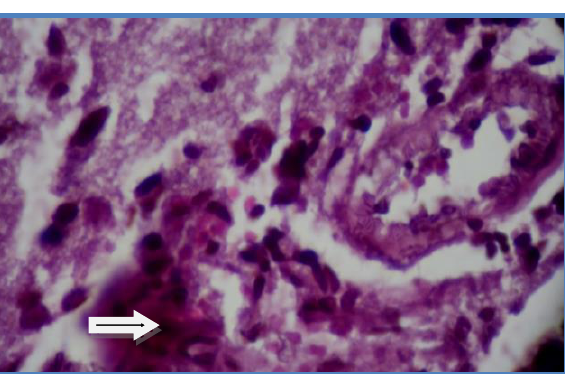
Figure, 4: Odema, Congestion of Capillary Alveoli and Slight Thickening of Alveolar Septae (interstitial pneumonia) in Infected Lung of Mice with Isolated BPIV- 3 Stained with (H and E)